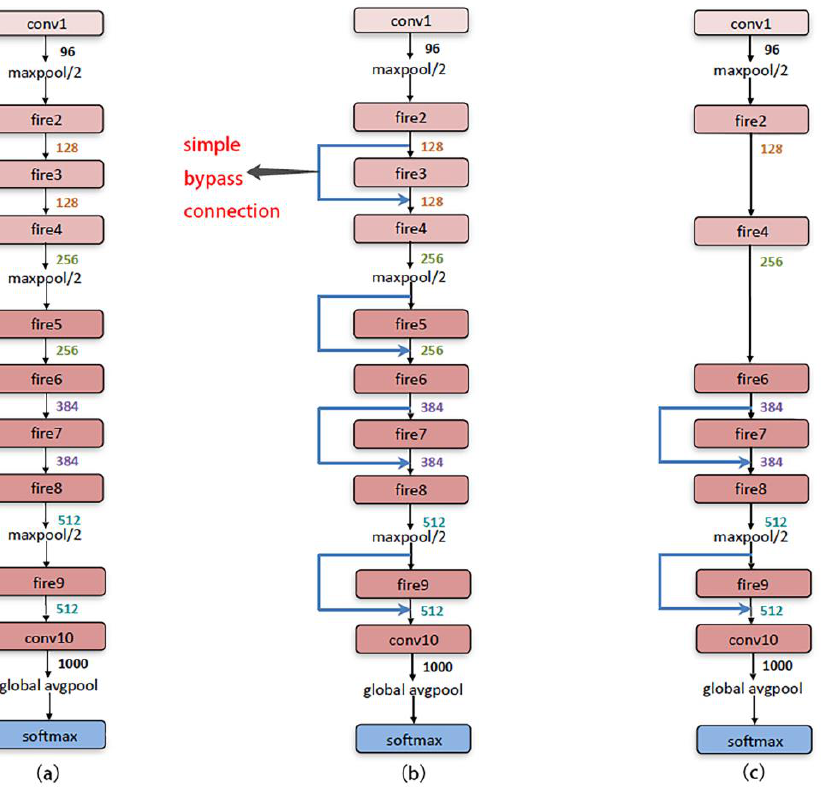
Figure 4. ( a ) SqueezeNet [27]; ( b ) SqueezeNet with simple bypass; ( c ) the improved model based on simple bypass connections. simple bypass